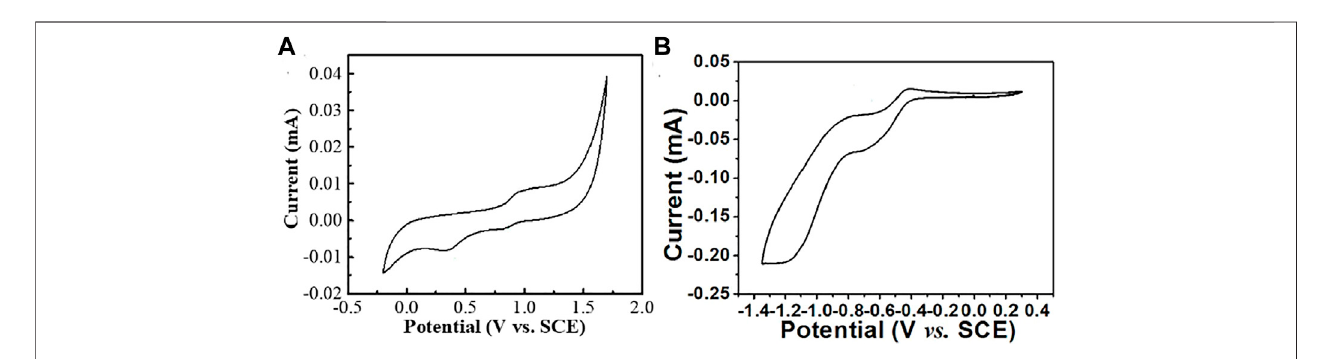
(cid:129) 2PF 6 − (B) .